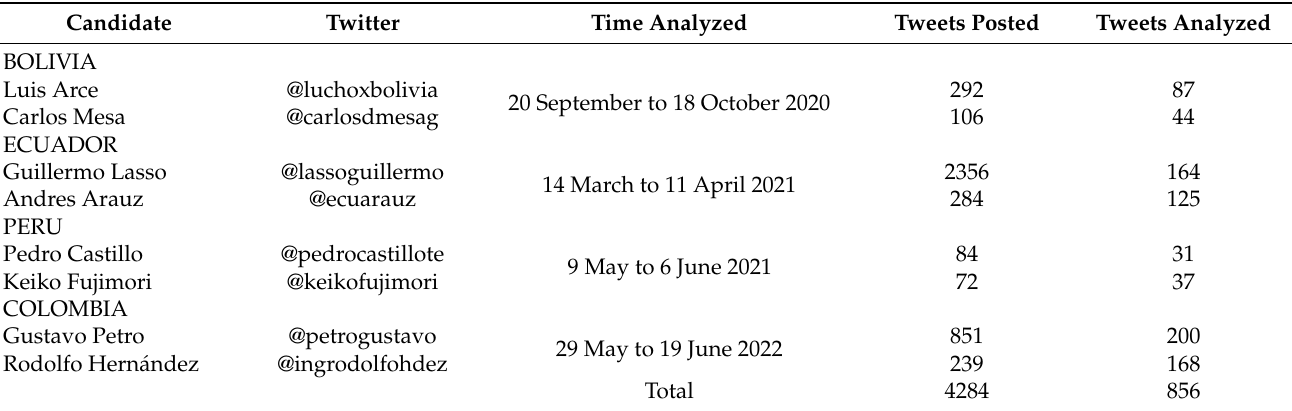
Table 1. Object of